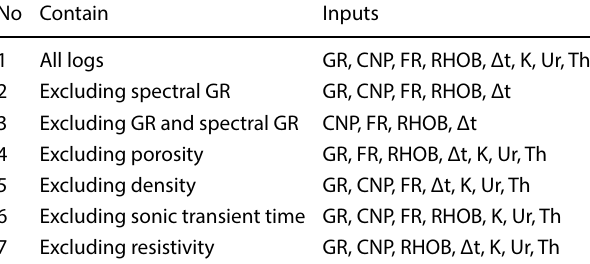
Table 5 Studied input sets